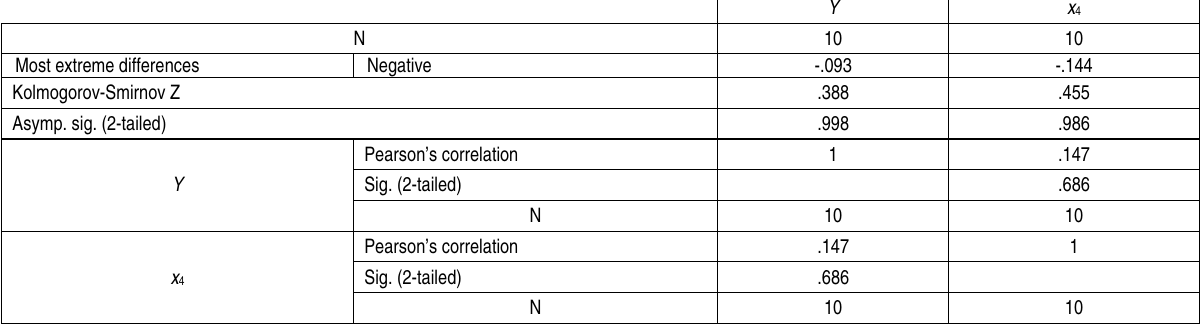
Table 16 (cont.). The fourth hypothesis test result (normality test and correlation analysis)